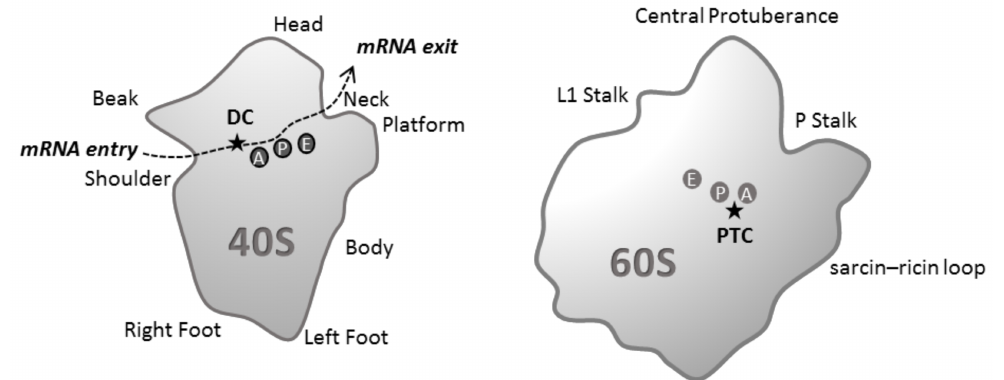
Figure 1. Schematic representation of the structural hallmarks and functional sites of the two mature ribosomal subunits (interface subunit view). The 40S subunit is organized in different structural regions: the body, the head, the shoulder, the beak, and the left and right feet. The 60S subunit structural landmarks are the central protuberance, the L1 and P stalks and the sarcin–ricin loop. Messenger RNA (mRNA) enters the mRNA channel through the mRNA entry site and exits through the mRNA exit site. The mRNA codon is read by its cognate transfer RNA (tRNA) in the decoding center (DC). The peptide bond formation occurs at peptidyl transferase center (PTC). The incoming aminoacyl tRNA enters in the A site, the P site holds the peptidyl tRNA, deacetylated tRNA binds the E site before it dissociates from the